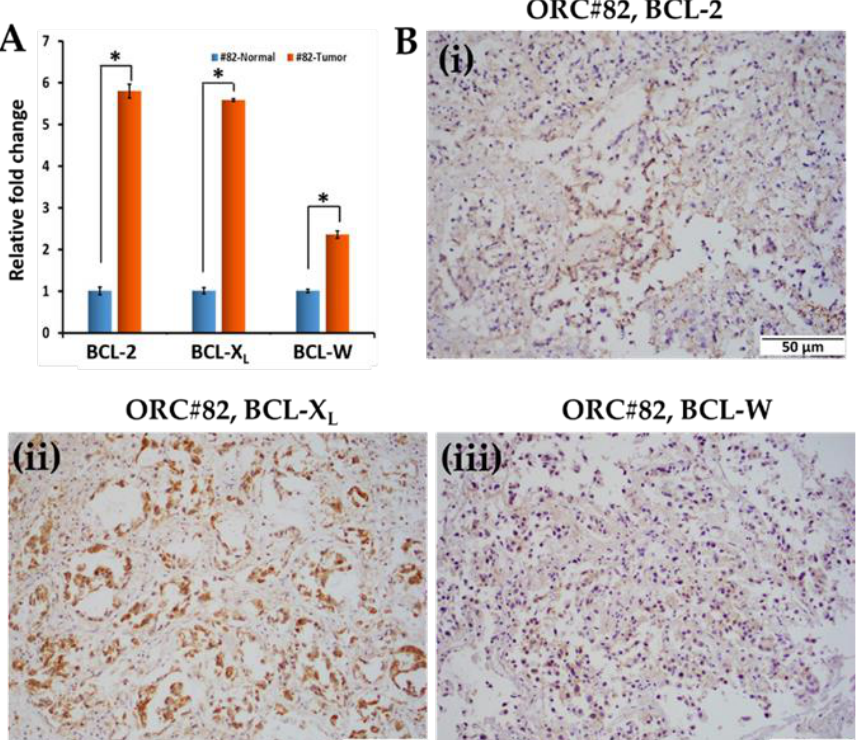
Figure 4. Gene expression in CRC-82 and immunophenotypic levels of antiapoptotic molecules in the organoids generated. ( A ) BCL-2, BCL-X L , and BCL-W in primary human CRCs (#82-Tumor) and its corresponding normal tissue (#82-Normal). ( B i – iii ) Immunohistochemical staining of BCL-2, BCL-X L , and BCL-W in organoids (ORC-82). All images are taken at 20× magnification (scale bar: 50 µm). The statistical significant values p ≤ 0.05 are denoted by asterisk *.